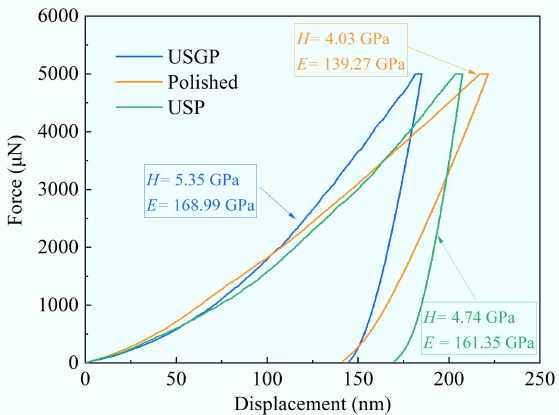
Figure 8. Load–displacement curves of the sub-surface of USGP sample, polished sample, and USP sample. The letters H and E stand for microhardness and elastic modulus, respectively.